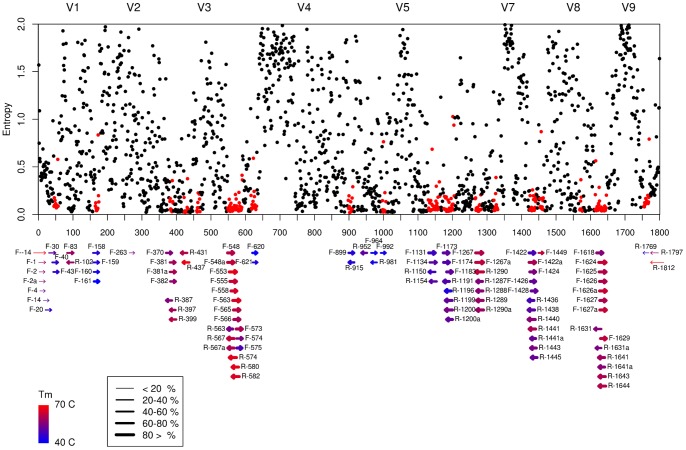
Nucleotide variability in 18S rRNA genes.Shannon entropy values of all eukaryotic alignment positions from the SILVA database along the 18S rRNA gene of Saccharomyces cerevisiae. Red dots mark consecutive nucleotide positions where at least 90% of ≥10 nt have entropy values lower than 0.2. The highly variable regions of 18S rRNA gene are denoted V1 to V9. In total, 100 primers targeting eukaryotes from the literature as well as those designed in this study are positioned along the reference sequence. The direction of the arrows indicates the orientation of the primers. The color denotes the melting temperature, and the thickness of the arrows represents the eukaryote universality of the primers.